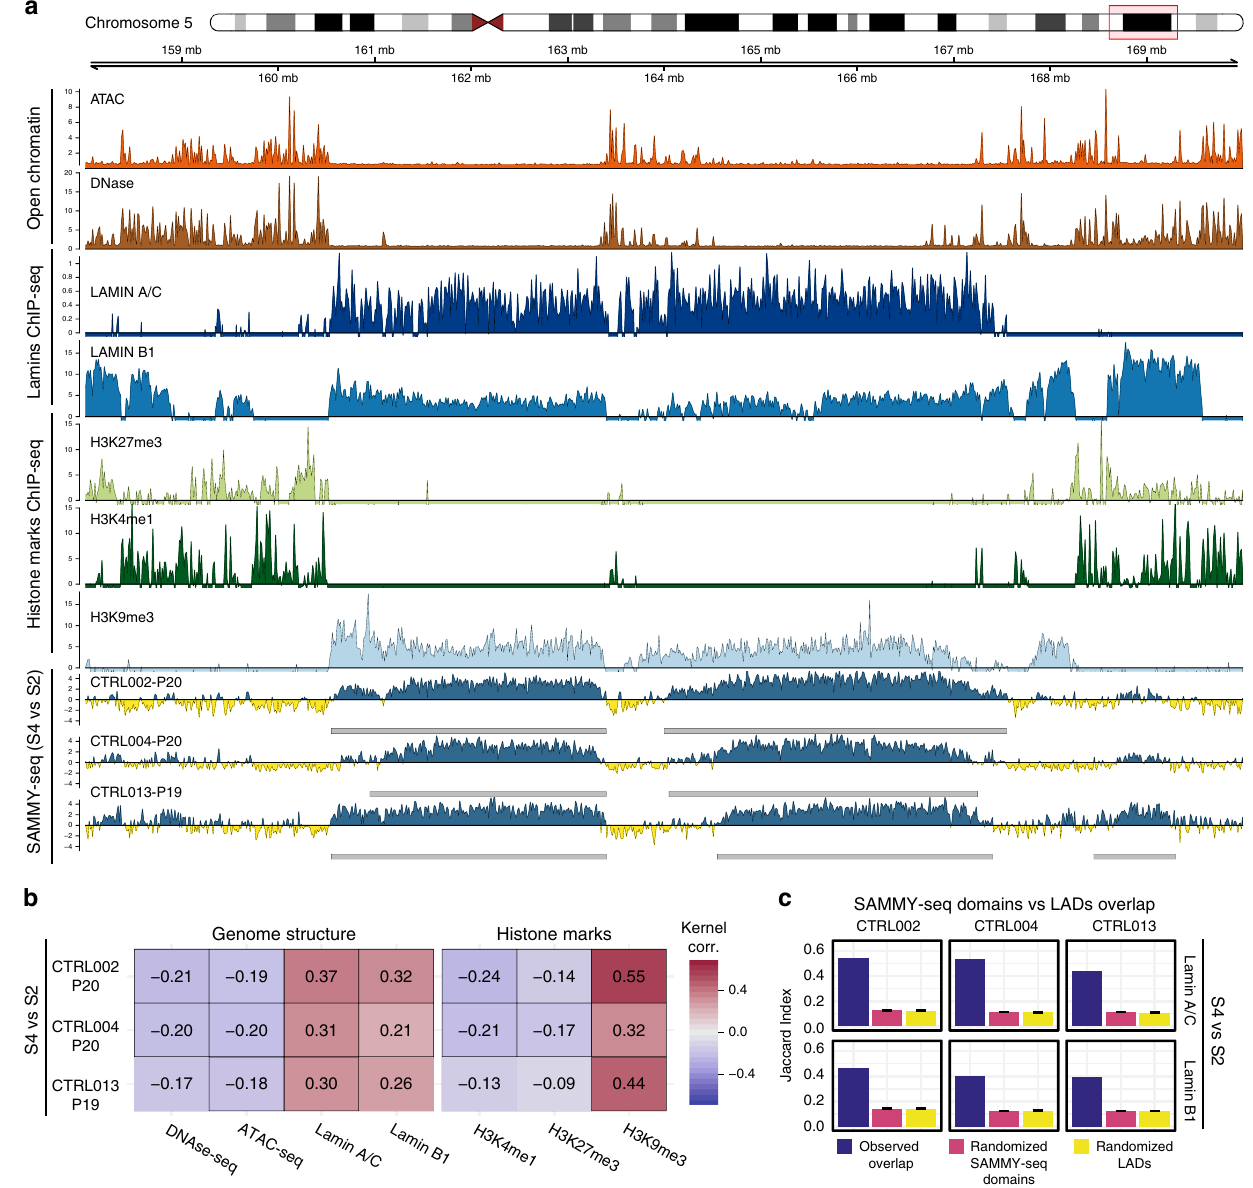
Fig. 2 SAMMY-seq preferentially isolates heterochromatic domains. a Visualization of SAMMY-seq enrichment signal along with multiple chromatin marks on a representative region (12 Mb region in chr5:158000000-170000000). From top to bottom: tracks for open chromatin (ATAC-seq and DNase- seq – orange and brown); association to the lamina (Lamin A/C and Lamin B1 ChIP-seq – dark blue and blue); ChIP-seq for histone marks associated to PcG regulation (H3K27me3 – light green), active chromatin (H3K4me1 – dark green) or heterochromatin (H3K9me3 – light blue); SAMMY-seq enrichment signal (S4 vs S2) in 3 control samples at indicated passages (p19-20) (blue or yellow colored track for enrichment or depletion, respectively, over the